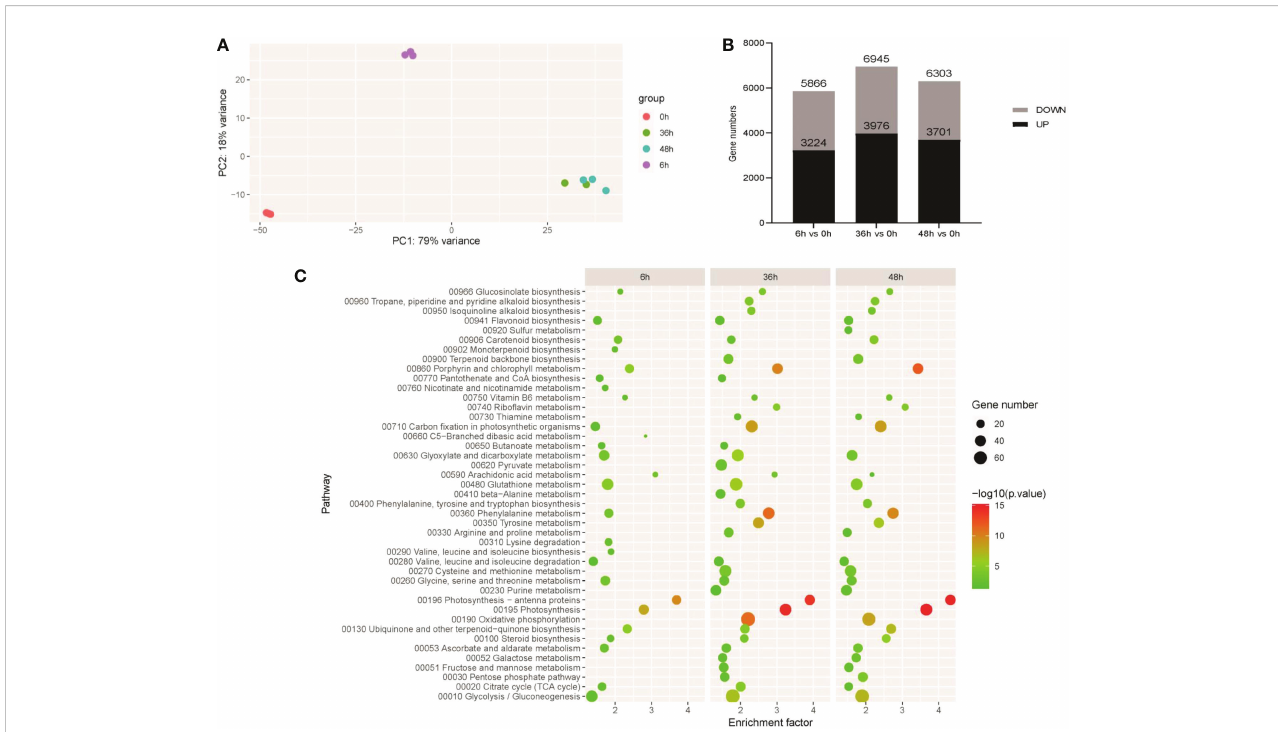
FIGURE 2 Overview of transcriptome analysis. (A) Correlation analysis of RNA-seq data of different treatments. (B) The number of differentially expressed genes (DEGs) in each comparison. (C) Kyoto Encyclopedia of Genes and Genomes (KEGG) enrichment analysis of DEGs in each comparison.